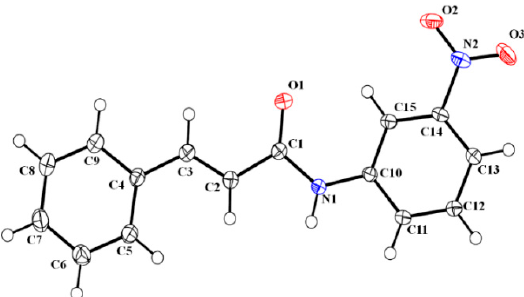
Figure 2. ORTEP view of Compound 1 , showing 50% probability displacement ellipsoids and atom labeling.